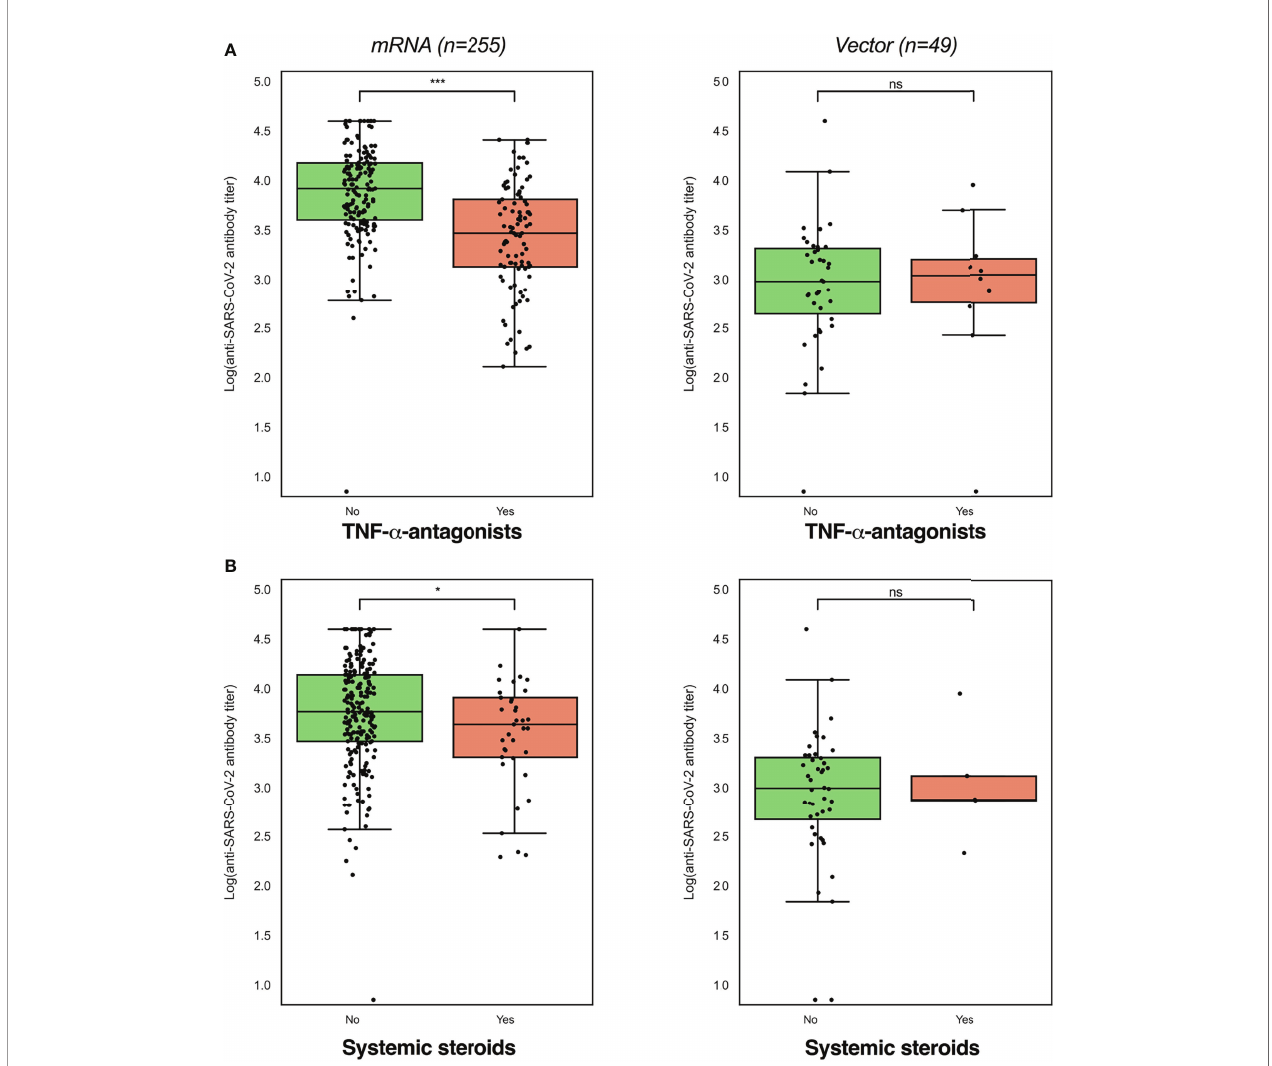
FIGURE 3 | Log-transformed anti-SARS-CoV-2 antibody titers were lowest in patients using TNF- a -antagonists (A) and systemic steroids ( B ), while these differences were dependent on the vaccine type received (mRNA or vector-type). Log-transformed anti-SARS-CoV-2 antibody titers were compared between users and non-users with independent sample t -tests (see Table 2 ). *P<0.05;